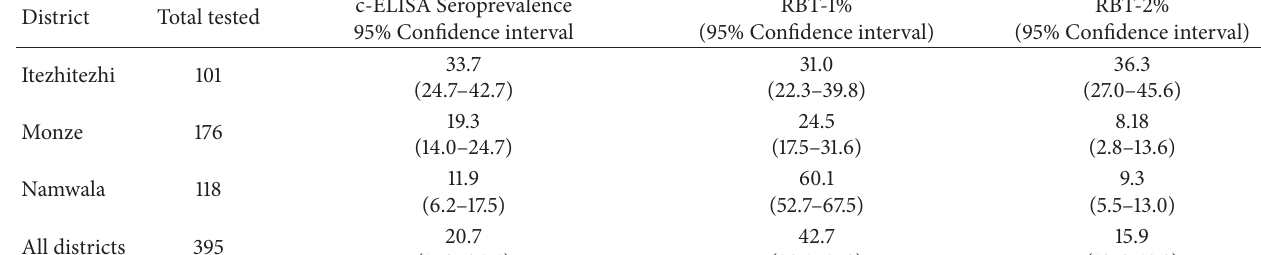
Table 6: Distribution of Brucella seropositive cattle ( 𝑛 = 395) in Southern Province of Zambia (2008).